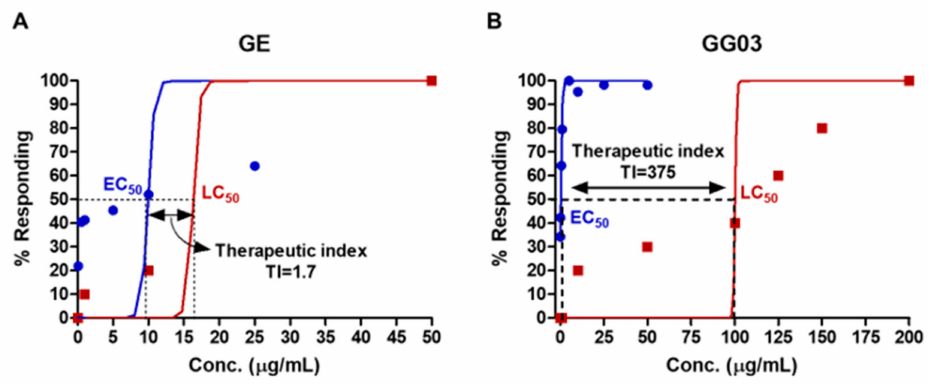
Figure 4. The therapeutic index (TI) of GE ( A ) and GG03 ( B ). The TI of GE and GG03 was 1.7 and 375, respectively.